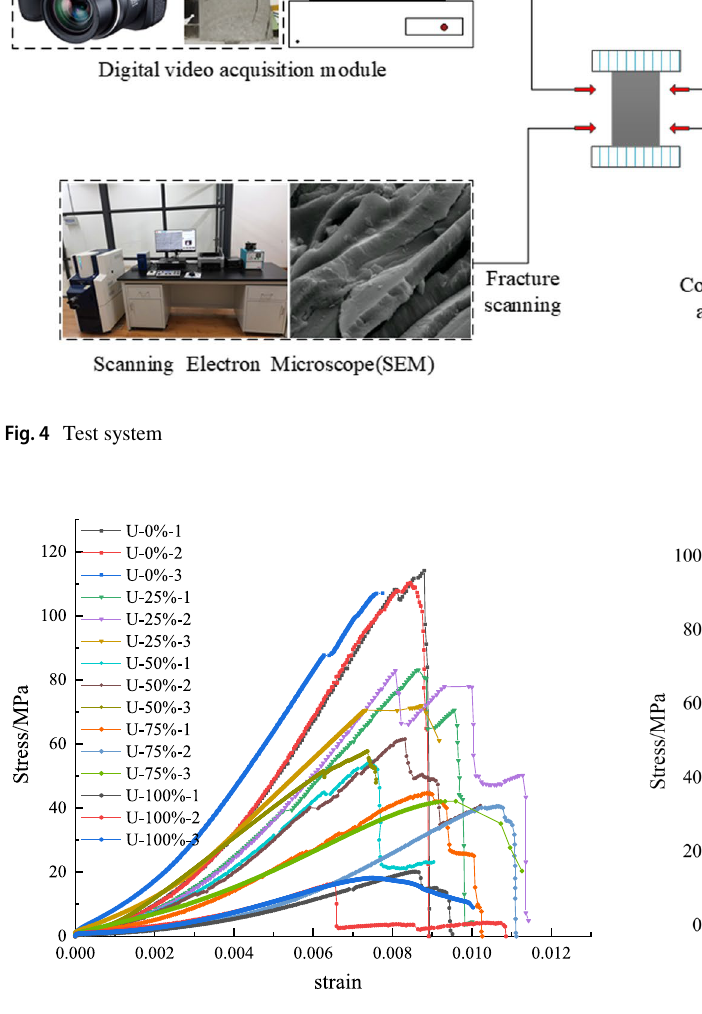
Fig. 5 Stress–strain curve under uniaxial loading